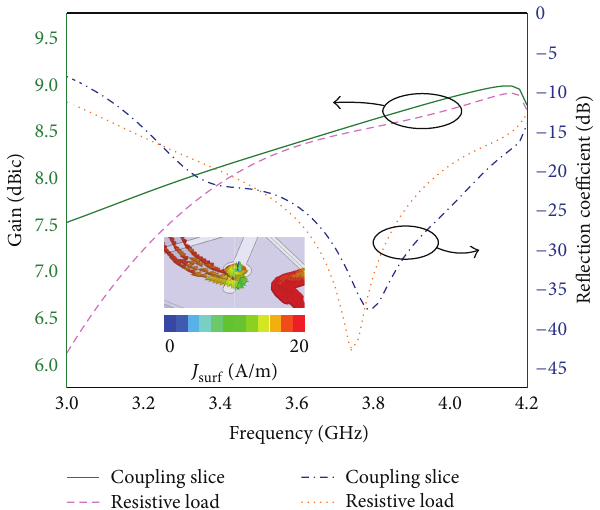
Figure 4: Comparisons of the gains and reflection coefficient of the antenna with coupling slice and resistive load, respectively.